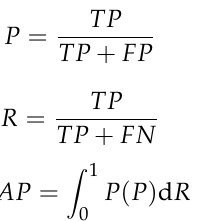
Table 5. Results of yolov5 in MSAR dataset.